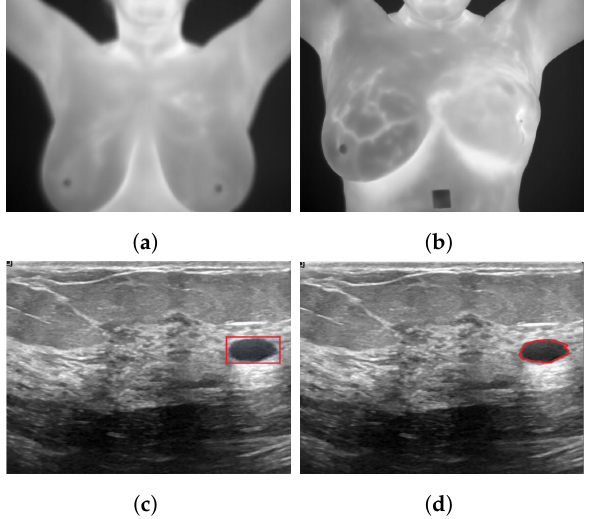
Figure 1. Sample applications of deep neural networks to breast cancer images for ( a ): classification as healthy using a thermogram; ( b ): classification as unhealthy using a thermogram [24]; ( c ): detection using ultrasound images; ( d ): segmentation using ultrasound images